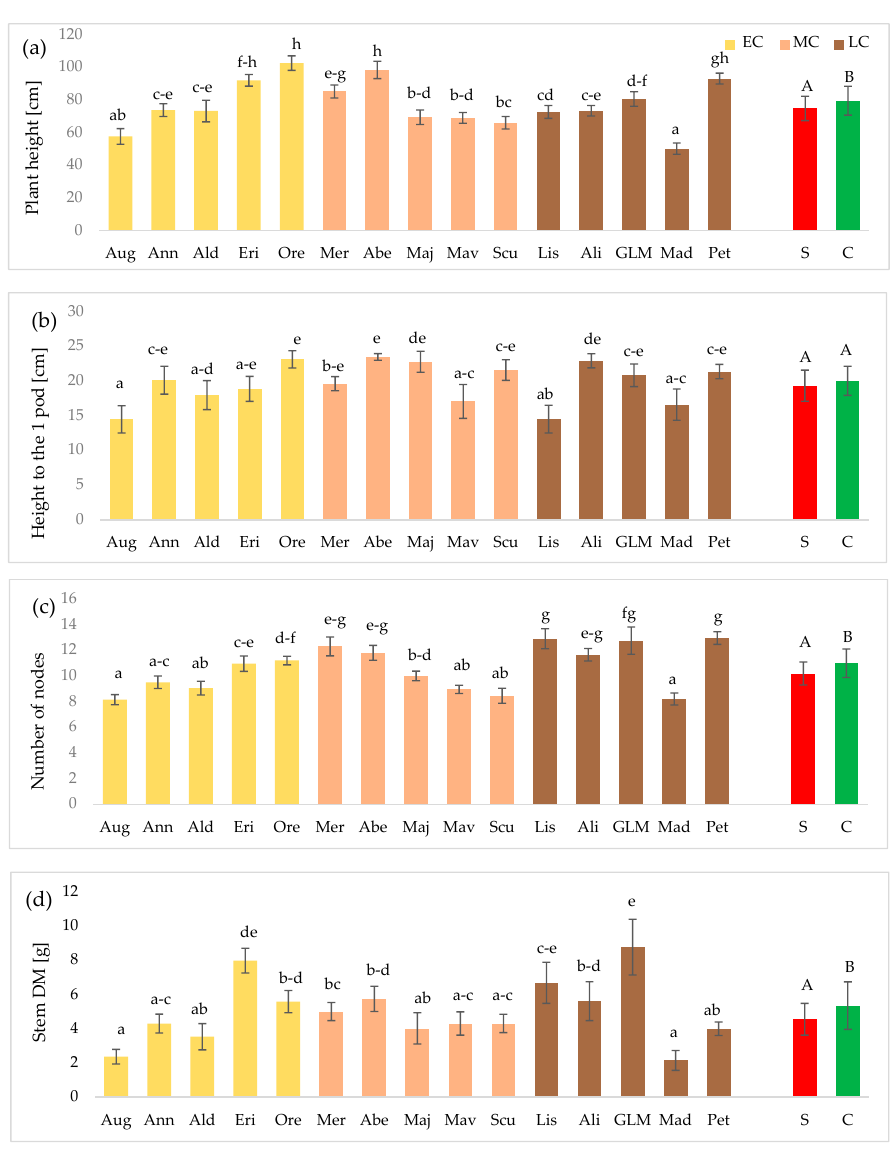
Figure 1. The effects of cold stress (n = 150) and cultivar (n = 20) treatments on the plant structure: plant height ( a ), height to the first pod ( b ), number of nodes ( c ), stem dry mass ( d ). Cultivars: Augusta (Aug), Annushka (Ann), Aldana (Ald), Erica (Eri), Oressa (Ore), Merlin (Mer), Abelina (Abe), Maja (Maj), Mavka (Mav), Sculptor (Scu), Lissabon (Lis), Aligator (Ali), GL Melanie (GLM), Madlen (Mad), Petrina (Pet); EC—very early and early cultivars, MC—medium–early cultivars, LC—late and very late cultivars Different lowercase letters indicate significant difference between cultivars, different uppercase letters—between treatment (cold stress (S) and control (C)) according to the Tukey test ( p = 0.05); ±SD.